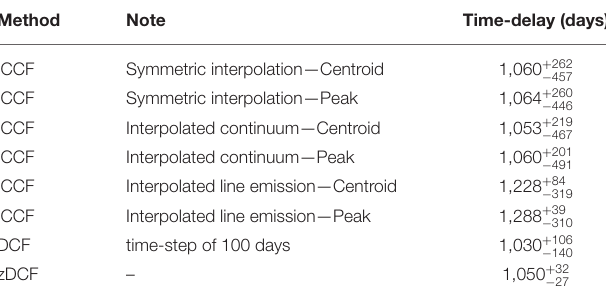
TABLE 1 | Summary of methods used for calculating the time-delays for the quasar and their uncertainties expressed with respect to the observer’s frame.